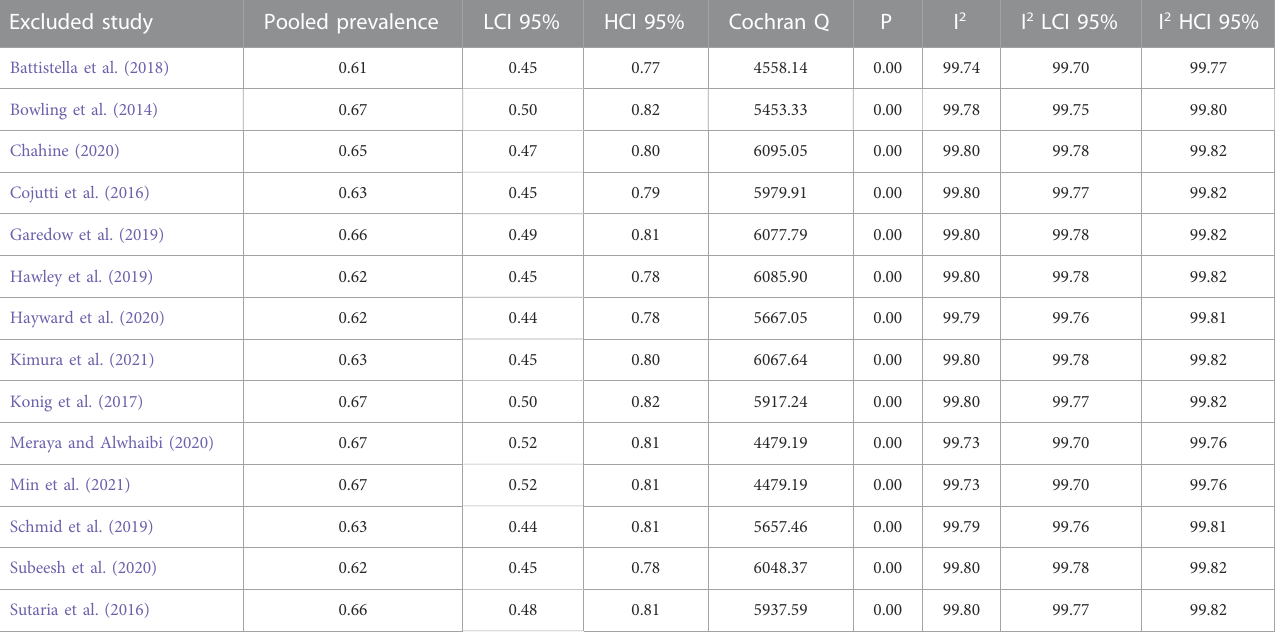
TABLE 3 Point estimates of the various included studies following sensitivity